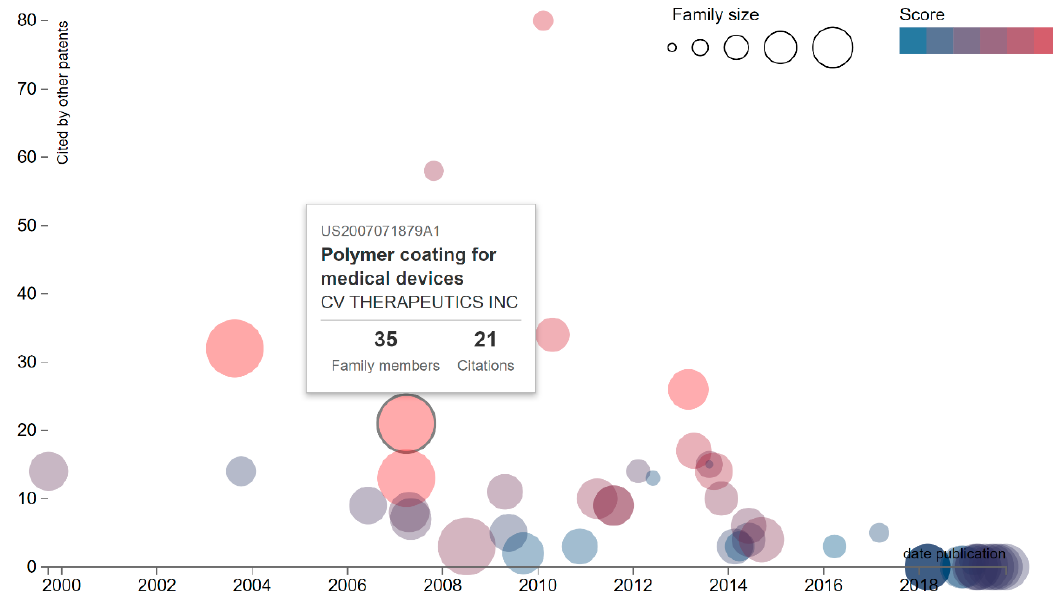
Figure 5. Patent value based on recency, family size, and forward citation size.